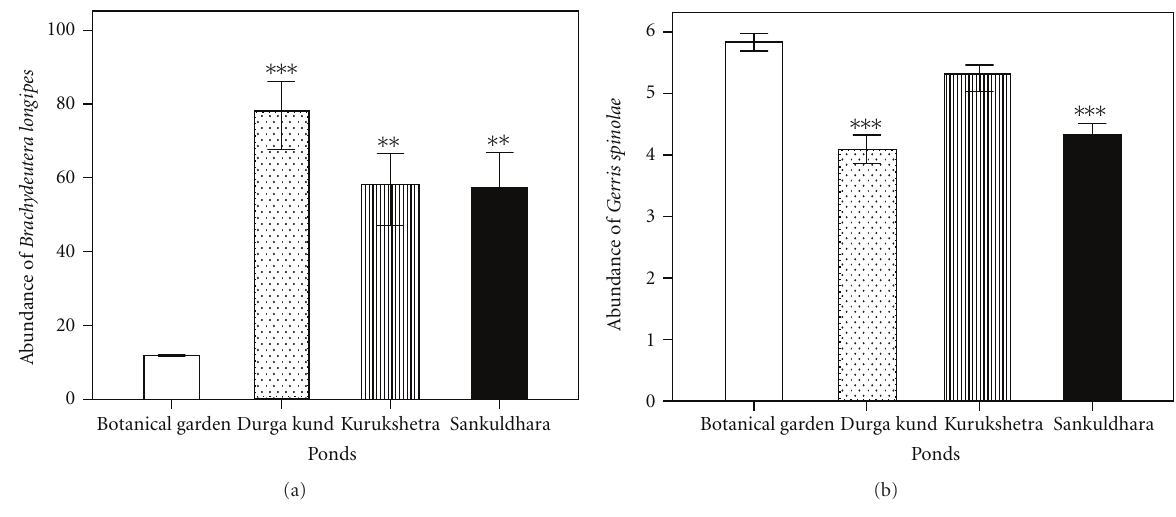
Figure 2: Abundance (No./sq. m) of adults of (a) Brachydeutera longipes (Hendel) and (b) Gerris spinolae (Lethierry and Severin) in the control (Botanical garden) and anthropogenically stressed (Kurukshetra, Sankuldhara and Durgakund) ponds, where ∗ P < 0 . 05, ∗∗ P < 0 . 01, and ∗∗∗ P < 0 . 001, ns—not